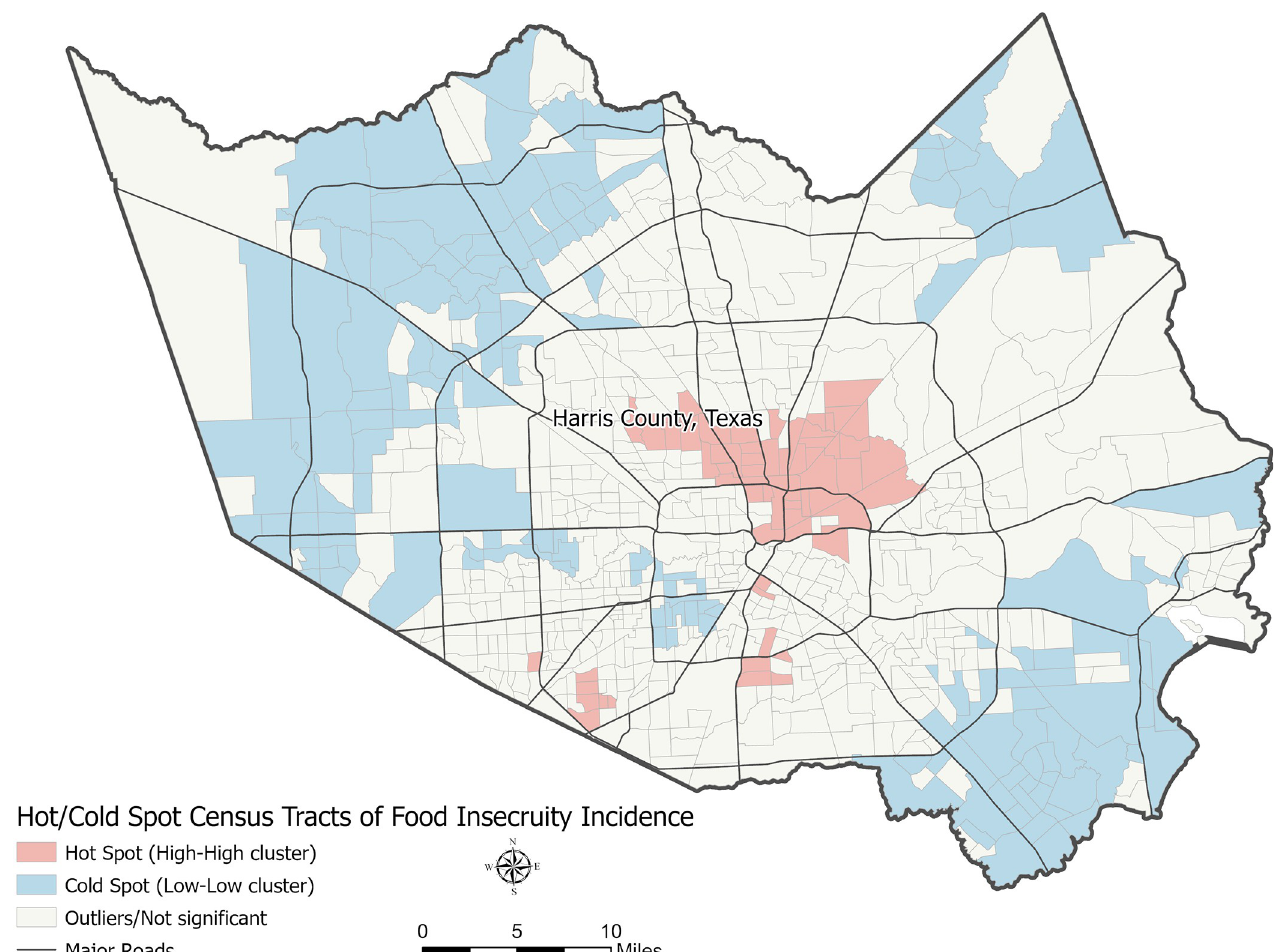
Fig 1. Hot/Cold spot map of food insecurity incidence, by